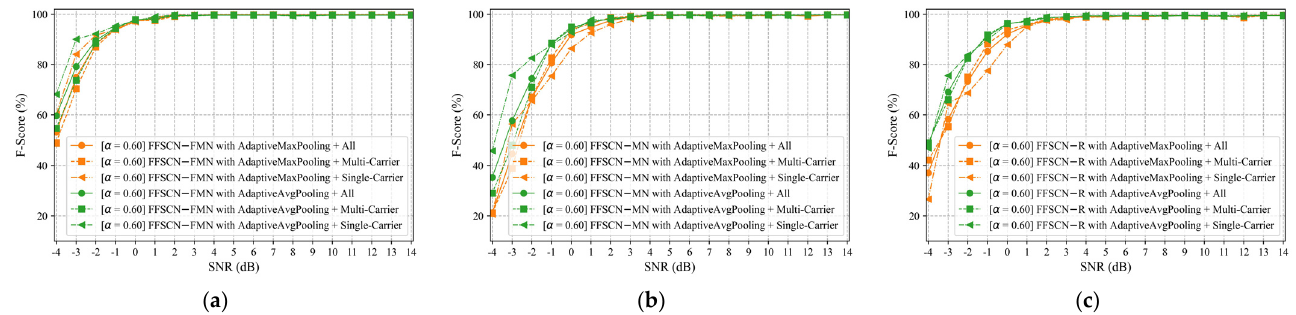
Figure 9. Effects of the two different adaptive pooling layer types used in the FFSCN models: ( a ) FFSCN-FMN; ( b ) FFSCN-MN; ( c ) FFSCN-R. Here, α denotes the IoU threshold, and we fixed it to 0.6.